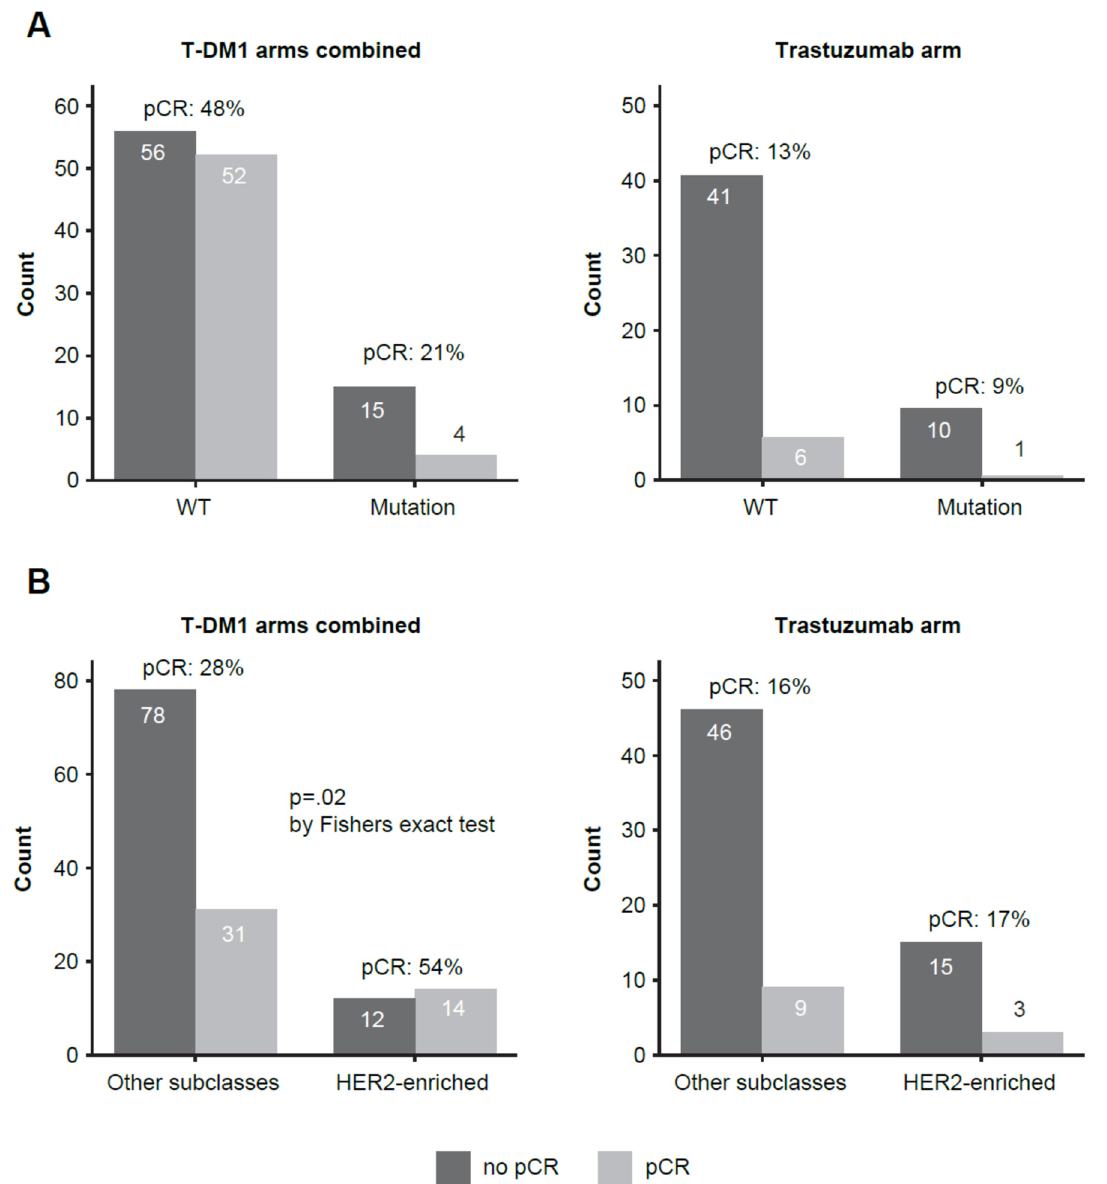
Figure 3. Overall pCR rates according to ( A ) PIK3CA mutation status and ( B ) in HER2-enriched tumors. p value calculated by Fisher’s exact test. pCR, pathological complete response; T-DM1, ado-trastuzumab emtansine; WT, wild-type.